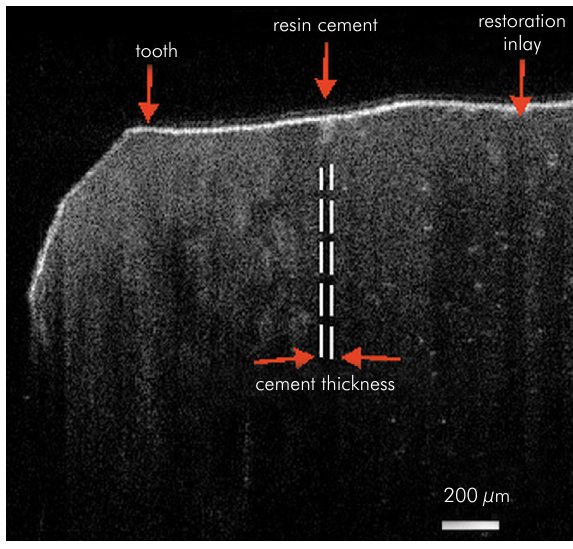
Figure 5. A representative transversal view of internal adaptation of ceramic inlay was measured through optical scan of internal resin